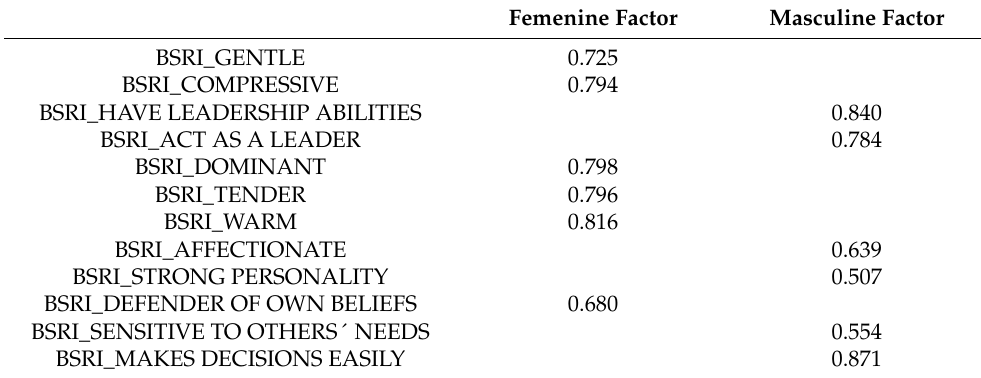
Table 3. Gender role characteristics (BSRI) in undergraduate Health Sciences students.